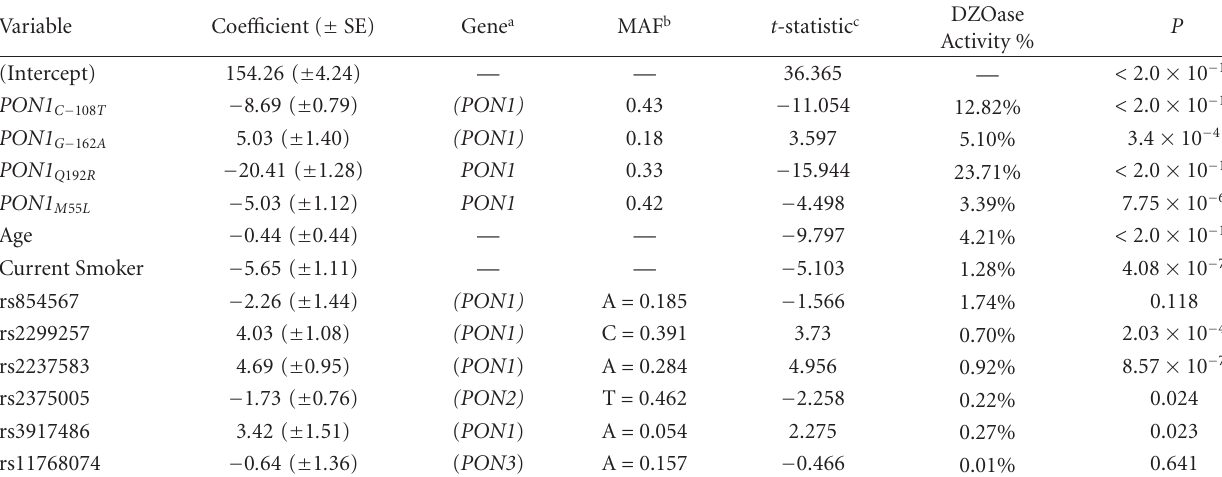
Table 4: Application of best-fit model for PON1 AREase activity to predict PON1 DZOase activity. Variable